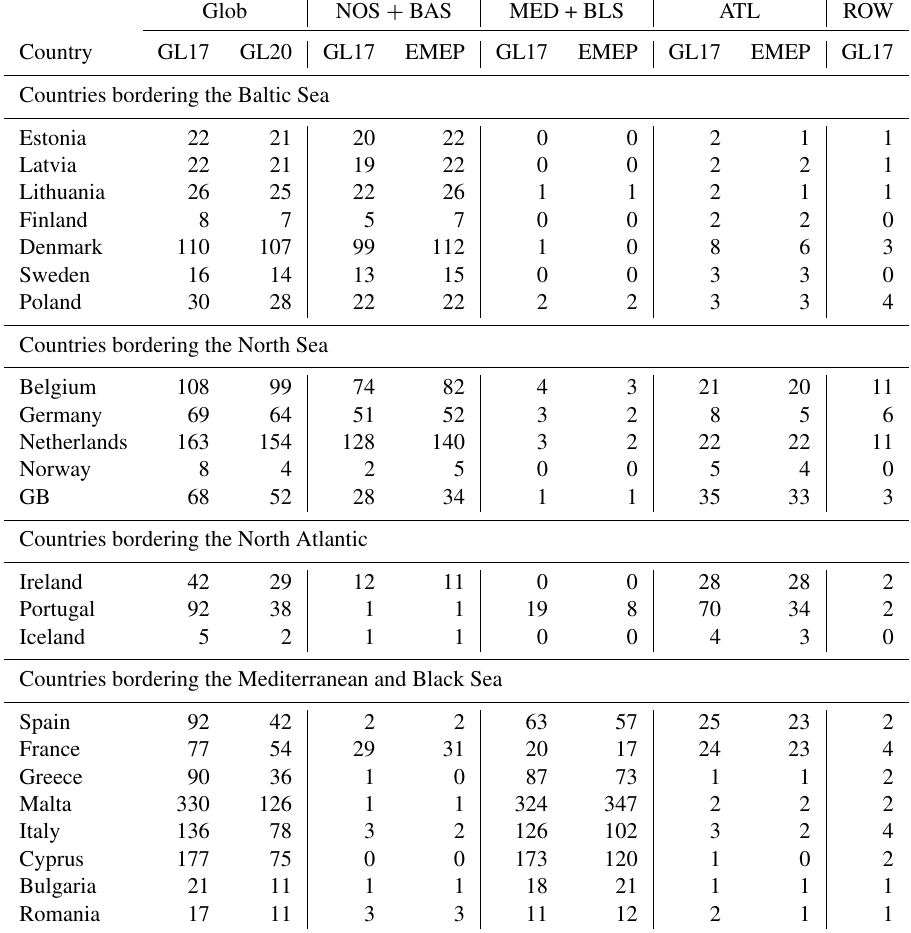
Table 3. Source receptor relationships for PM 2 . 5 from shipping. GL17 and GL20 are calculated with the global model with 2017 and CAP2020 ship emissions respectively. The scenario calculations are made reducing the ship emissions for all species by 15%. EMEP is the source receptor calculations for 2017 from the latest EMEP report (Appendix B in EMEP Status Report 1/2019, 2019). The EMEP source receptor report is based on separate calculations of individual species from all European countries and sea areas. Glob is the contribution from all global shipping, NOS + BAS from the North Sea and Baltic Sea combined, MED + BLS from the Mediterranean Sea and Black Sea combined, and ATL from the north-east Atlantic. ROW includes all ship emissions outside the individual sea areas listed. For the EMEP, reported boundary and initial contributions are listed (units: ngm − 3 per 15% emission